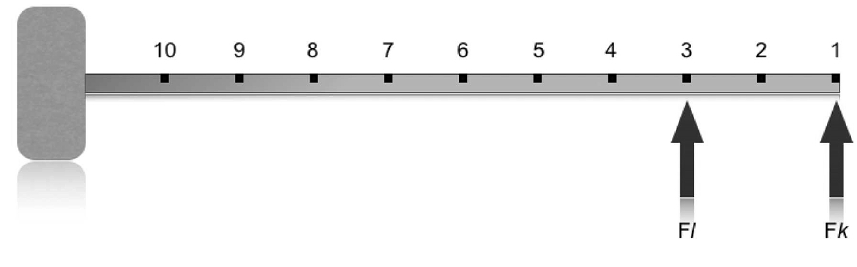
Fig. 1. Cantilever beam.